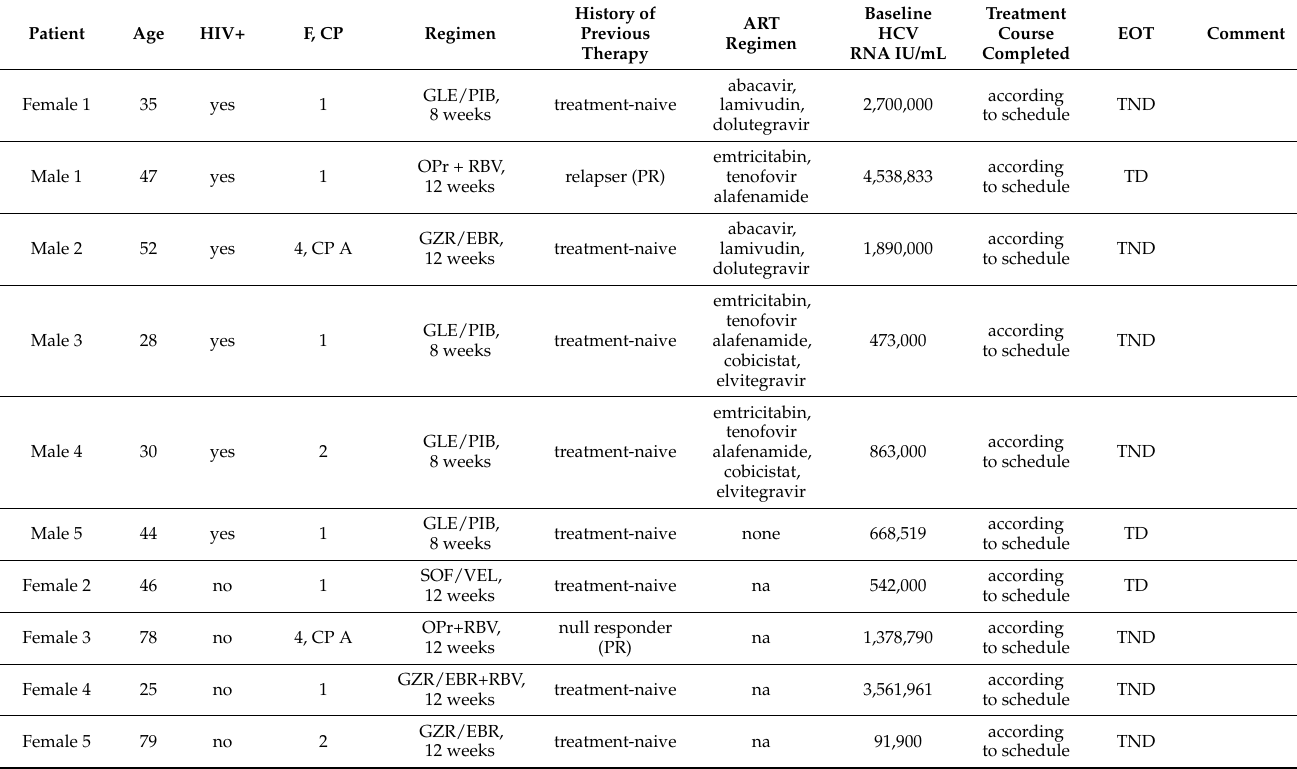
Table 5. Characteristics of 13 virologic